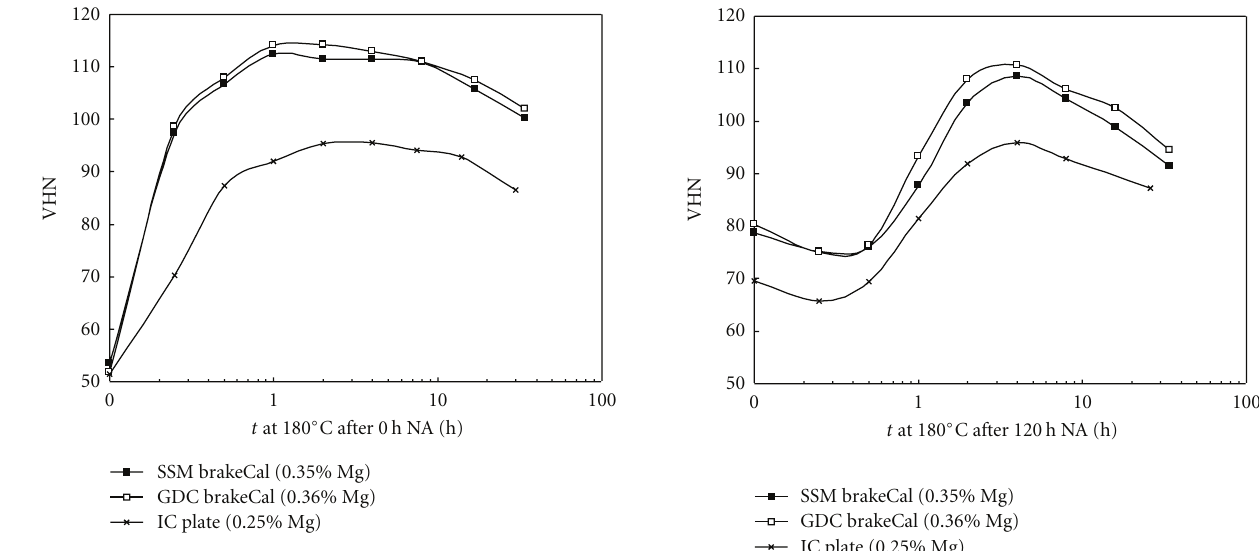
Figure 4: Artificial aging curves at 180 ◦ C for alloy A356 cast using di ff erent casting techniques (after 0h prior natural aging time). Figure 5: Artificial aging curves at 180 ◦ C for alloy A356 cast using di ff erent casting techniques (after 120h prior natural aging